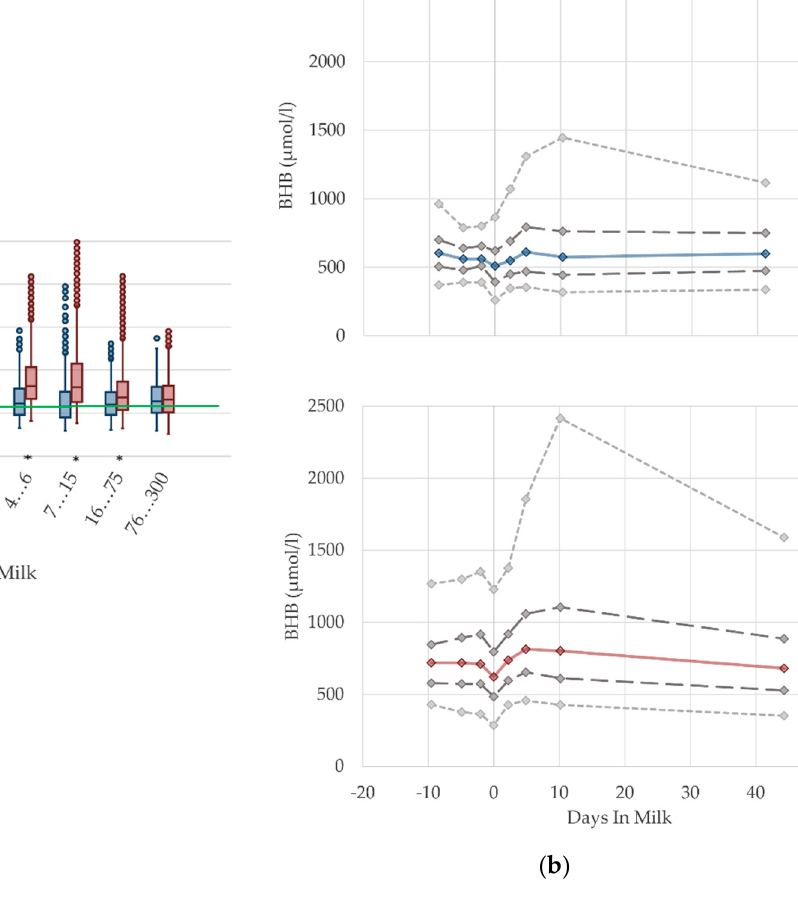
Figure 2. Serum concentrations of beta-hydroxybutyrate (BHB) in primiparous (blue) and in multiparous (red) cows ( a ) in 10 classes between 30 days prepartum to 300 days postpartum (boxplots), green continuous lines represent the reference values according to Fürll [23], asterisk indicates significant differences regarding parity within DIM class; and ( b ) in 8 classes from 10 days prepartum to 40 days postpartum (median—continuous line; 1st and 3rd quartile—dashed lines; percentile 5 and 95—dotted